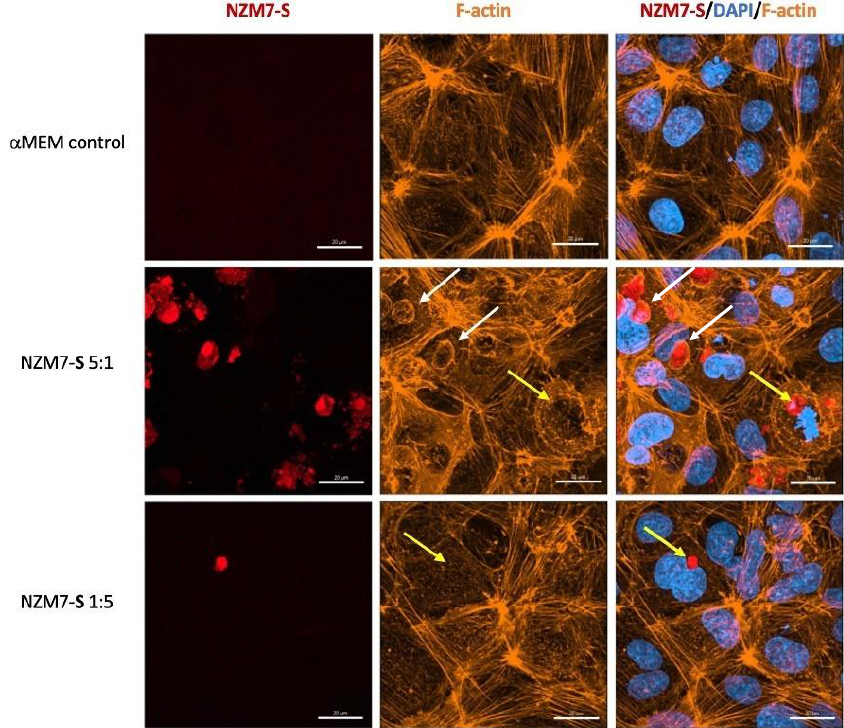
arrows highlight stretched junctional borders. Yellow arrows highlight punctate CD144 staining within the endothelial cell body. Images were acquired with the Zeiss LSM 800 Airyscan confocal microscope. Scale bars = 20 µ m.